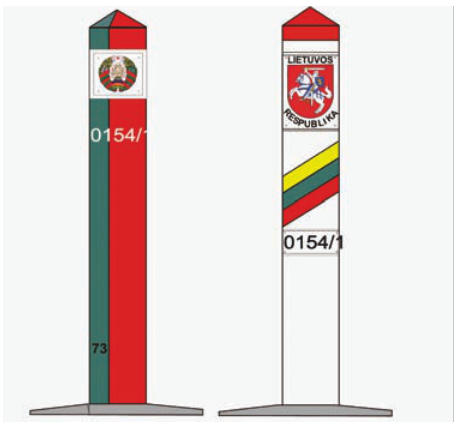
Fig. 2. Intermediate state border mark